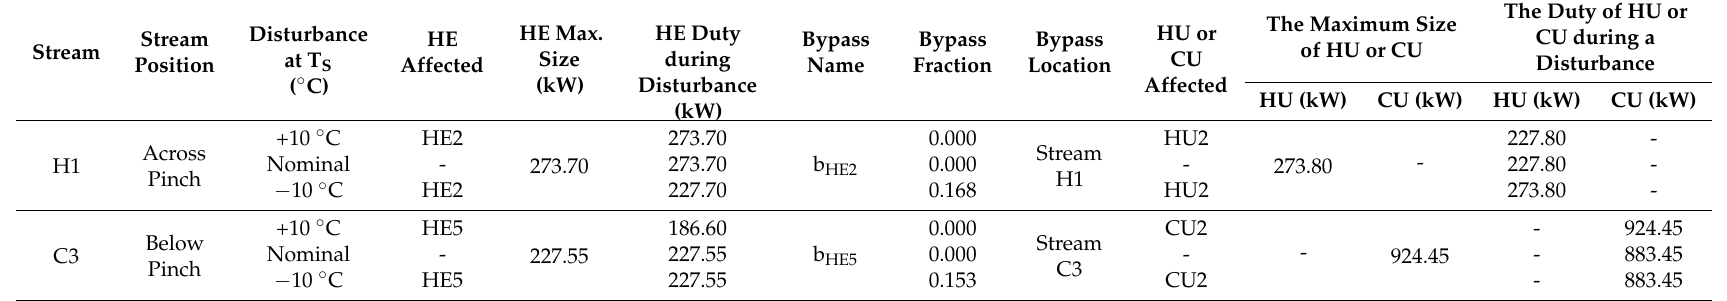
Table 6. Analysis of bypass and utility requirements of HEN design with nominal HE area.